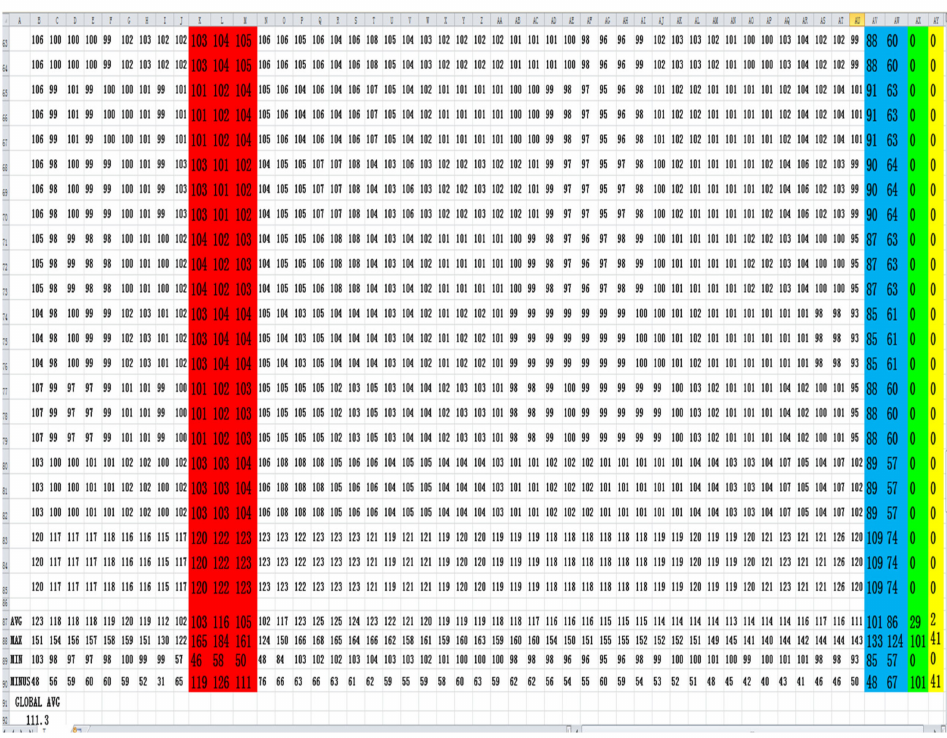
Figure 5. Column detection results of the steel